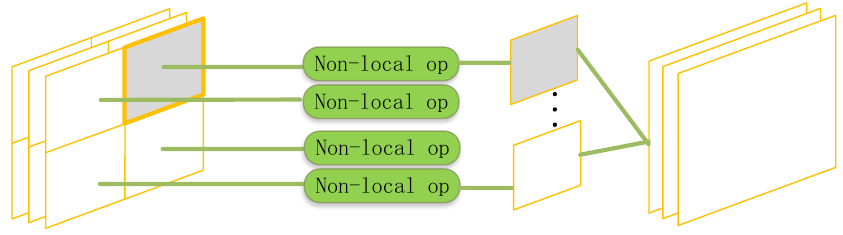
Figure 5. Decomposition of non-locally enhanced